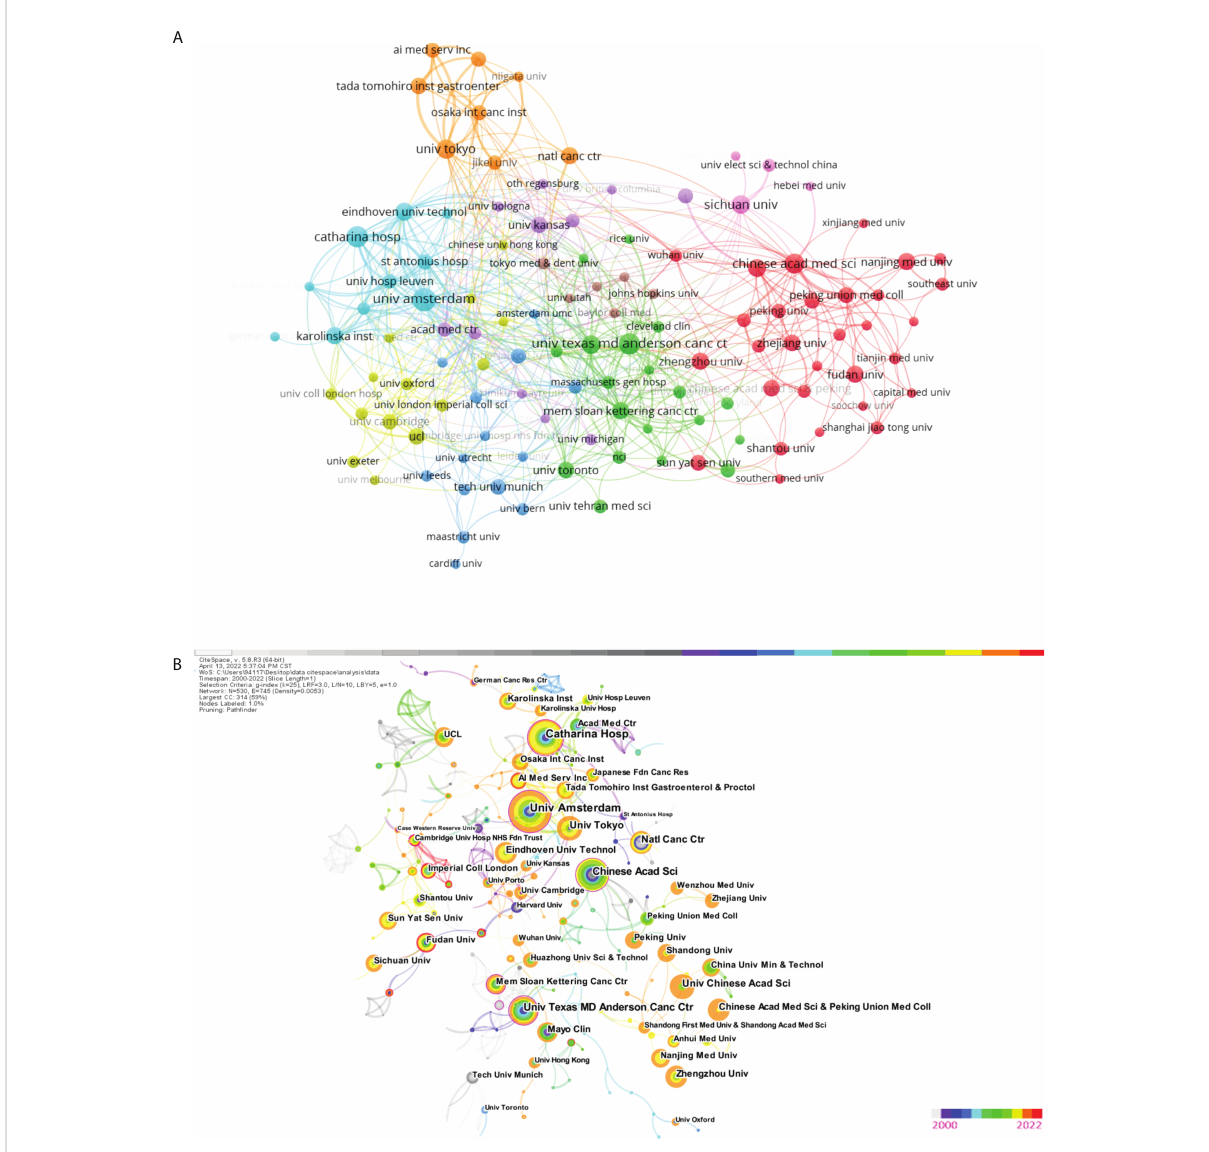
FIGURE 5 (A) The citation network visualization map of institutions was performed with VOSviewer. (B) Co-institutions' network (2000-2022). The color of the circle represents when the article was published. The larger the node diameter, the more papers institutions have published. The thicker the line between the nodes, the closer the two institutions work together. The outermost purple circle indicates that this institution has a very strong intermediary role in the fi eld